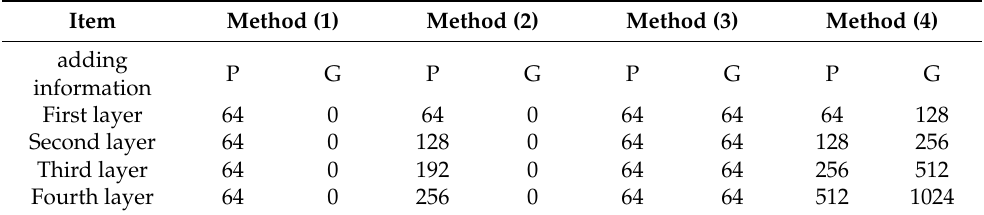
Table 4. Different layer sizes number on each layer for individual point-level and global information